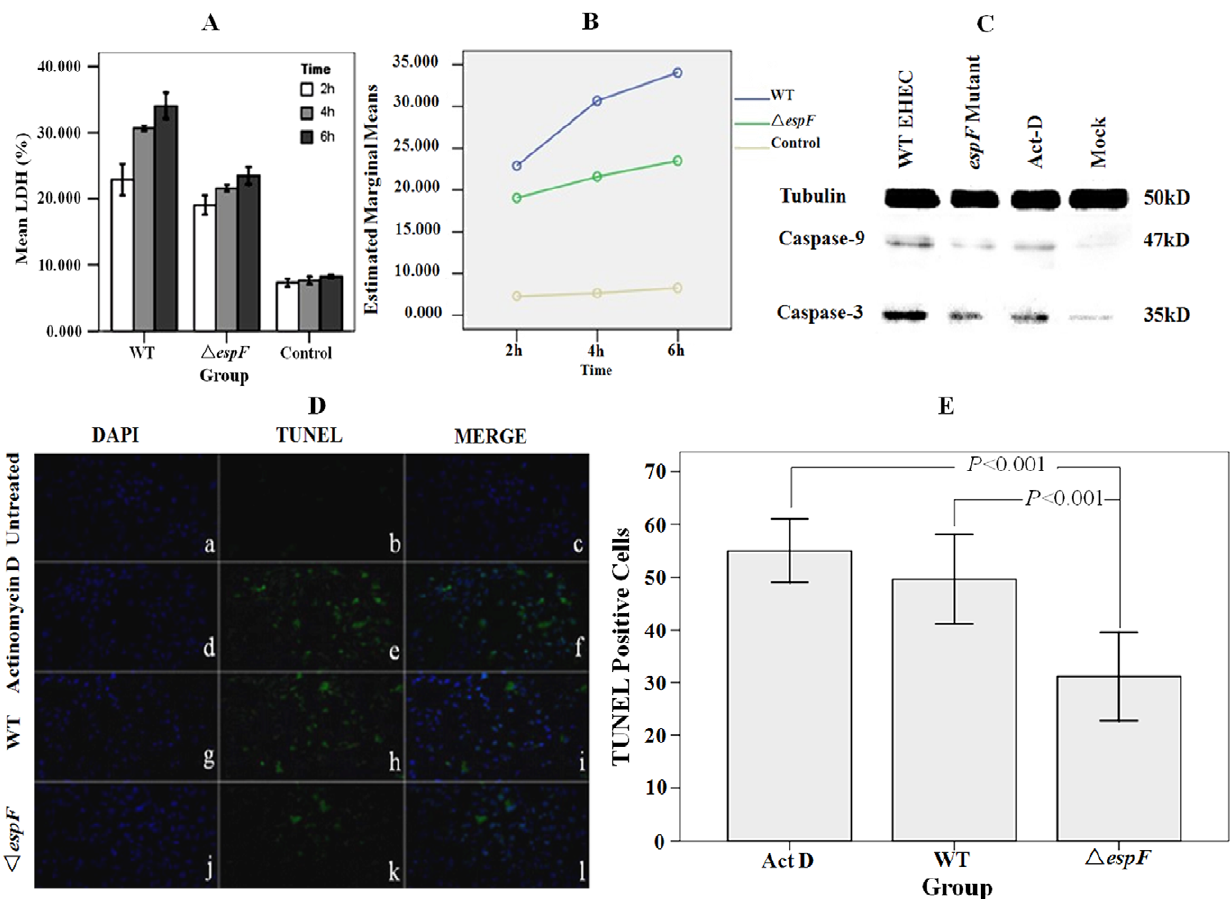
Figure 2. The EHEC effector protein EspF induces Lovo cell apoptosis post EHEC infection. (A) LDH release rate comparison of Lovo cells infected with wild type, D espF , and DH5 a groups at 2, 4, and 6 h; results show mean 6 SD (n=3). (B) Estimated marginal mean of LDH release rates of wild type, D espF , and DH5 a groups. (C) Detection of caspase-9/3 in infected Lovo cells. Cells were untreated (mock), treated with EHEC WT, D espF strains and the apoptosis inducer actinomycin D (Act-D) respectively for 3h. (D) TUNEL test fluorescent images of Lovo cells infected with EHEC. (b, e, h, k): cells untreated, treated with Act-D, infected with EHEC WT, D espF respectively, and immunostained with TUNEL. (a, d, g, j): cells counterstained with DAPI and observed based on fluorescence microscopy. (c, f, i, l): merged images of TUNEL and DAPI treated cells. (E) Quantification of TUNEL- positive cells. Dead cells were stained by TUNEL assay and TUNEL-positive cells were counted based on fluorescence microscopy; results showed mean 6 SD (n=3); P , 0.001 for all